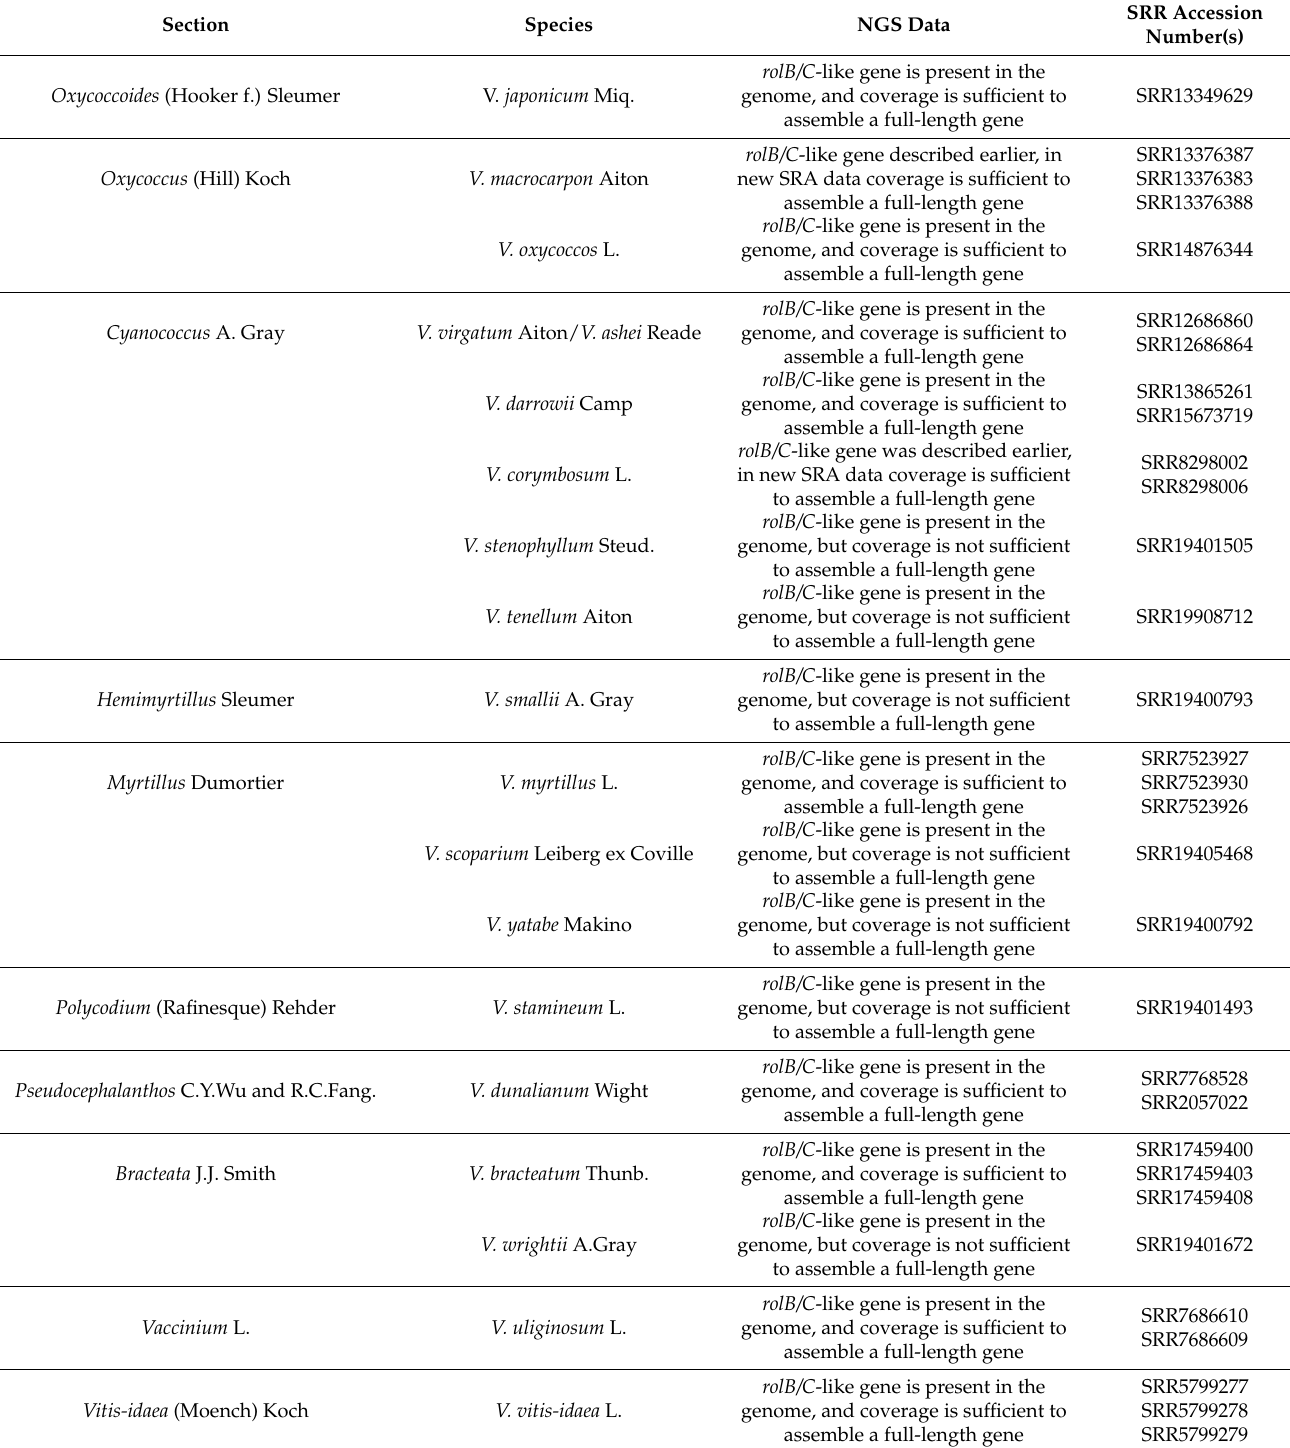
Table 1. Natural transgene of Vaccinium species, based on NGS